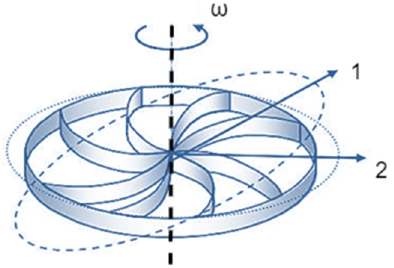
Figure 1. Circular